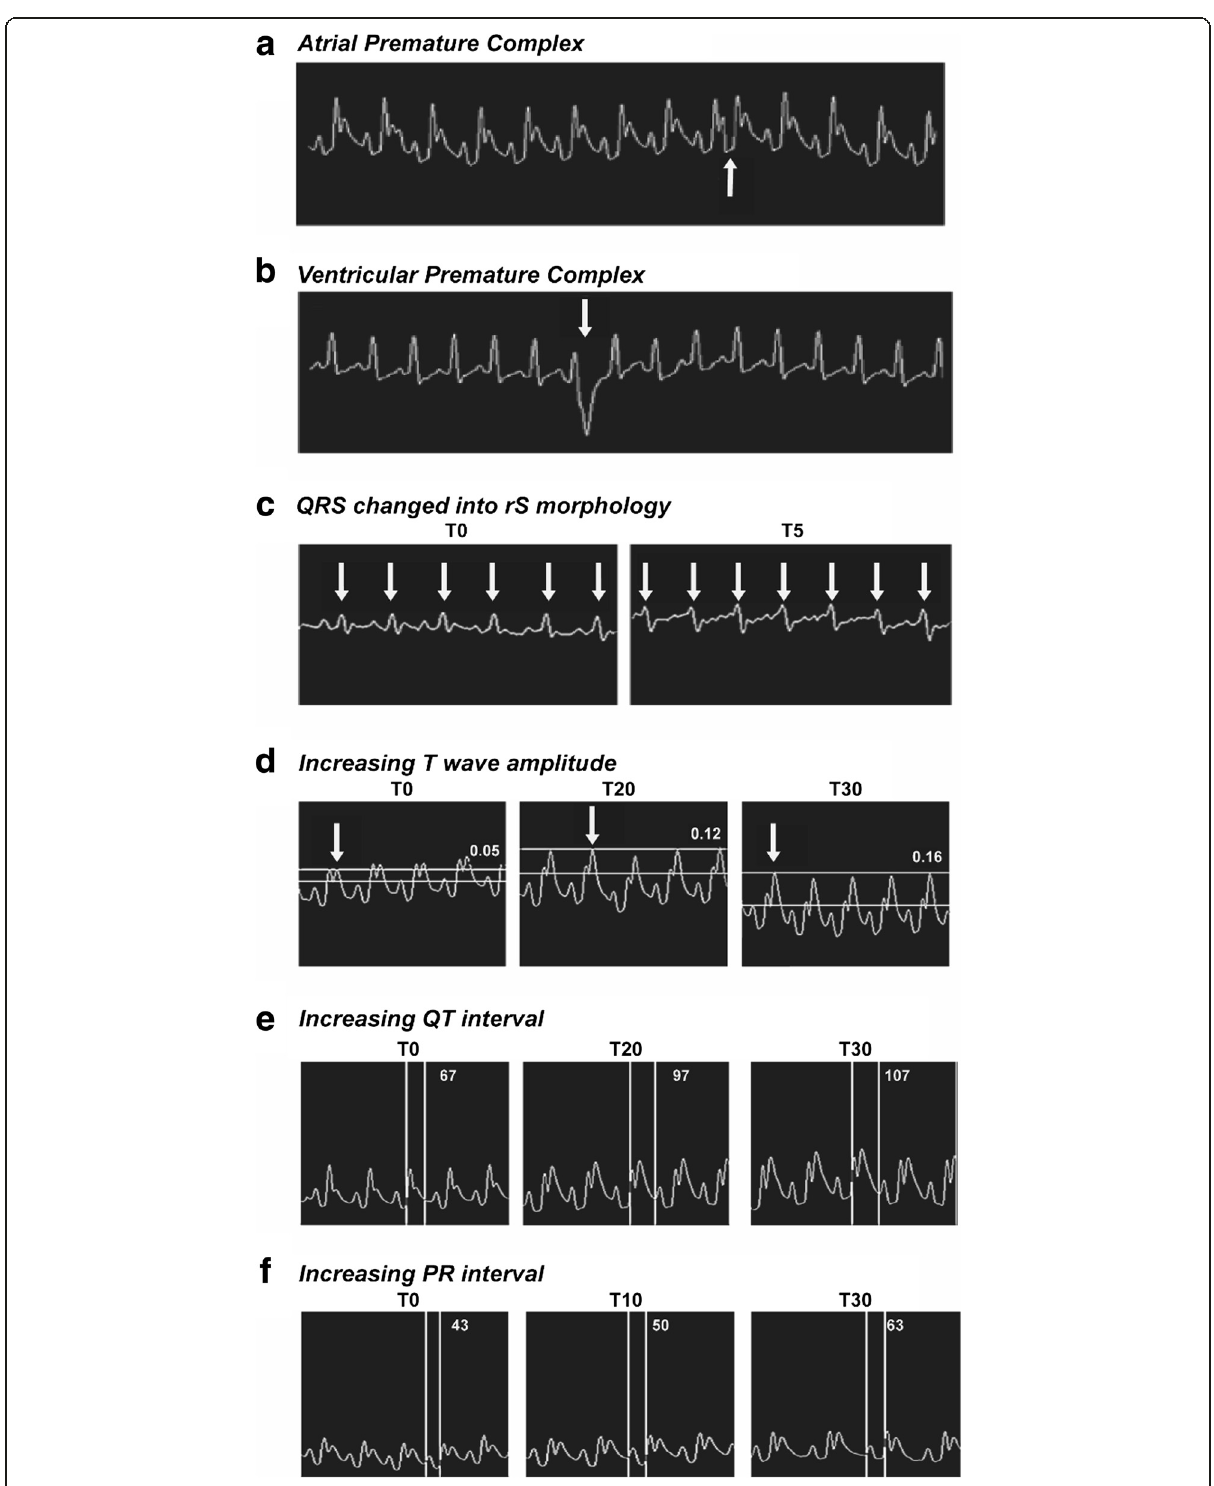
Fig. 3 Electrocardiogram alterations in animals treated with Hlsv . ECG from two animals of the treated group showing ( a ) atrial premature complex and ( b ) ventricular premature complex 15 min after the envenomation. ( c ) At T0, all QRS complexes were normal. At T5, all complexes changed the morphology to rS wave. Velocity 50 mm/s, sensibility 2 N, lead II. ( d ) At T0, T wave was 0.05 mV. At T20, T wave more than doubled its amplitude, reaching 0.12 mV. At T30 T wave was 0.16 mV. ( e ) Increase on QT interval from 67 ms at T0, to 97 ms at T20 and 107 ms at T30. ( f ) Increase on PR interval from 43 ms at T0, to 50 ms at T10 and, then, to 63 ms at T30. Velocity 50 mm/s, sensibility 2 N, lead